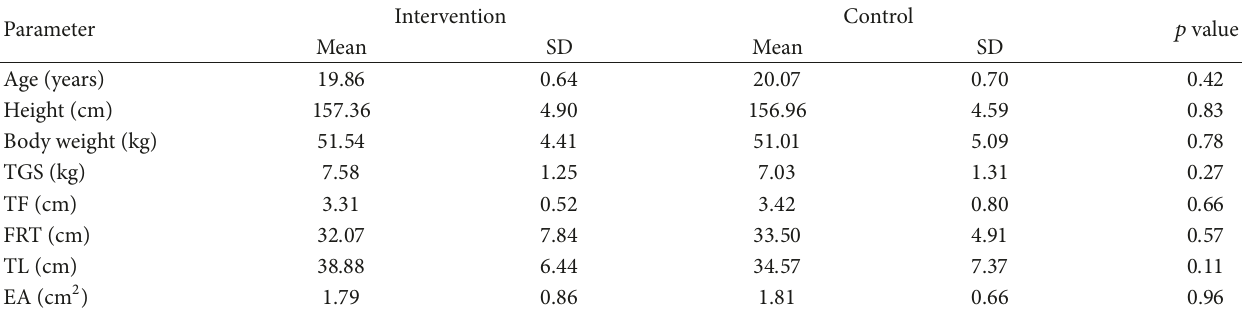
Table 1: Characteristics of the intervention ( 𝑛 = 14 ) and control groups ( 𝑛 = 14 ). Parameter